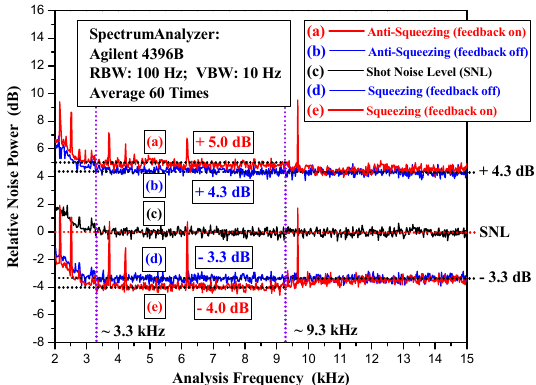
Figure 4. Relative noise power spectra normalized to the shot noise level (SNL) for the squeezing phase and the anti-squeezing phase. The two cases with and without both the 795-nm NIR and the 397.5-nm UV intensity noise feedback loops are compared. The traces (a) and (e) indicate the anti-squeezing of + 5.0 dB and the squeezing of − 4.0 dB for the case with feedback. The traces (b) and (d) indicate the anti-squeezing of + 4.3 dB and the squeezing of − 3.3 dB for the case without feedback. The trace (c) shows SNL. Clearly in the analysis frequency range from ~3.3 to ~9.3 kHz the squeezing is improved from − 3.3 to − 4.0 dB with help of both the 795-nm NIR and the 397.5-nm UV intensity noise feedback loops. In fact, there is a significant loss in the path from the OPO output coupling mirror to the BHD, including the round trip losses (~3%) of light and limited quantum e ffi ciency (~97%) of BHD we utilized, which directly lead to an underestimate of the squeezing level. Therefore, we can infer that the true squeezing level of audio-frequency squeezed vacuum state of light is 0.2–0.3 dB higher than we detected. The noise power spectra are measured with a spectrum analyzer (Aglient 4396B, USA) and averaged for 60 times. The resolution bandwidth (RBW) is 100 Hz, and video bandwidth (VBW) is 10 Hz.